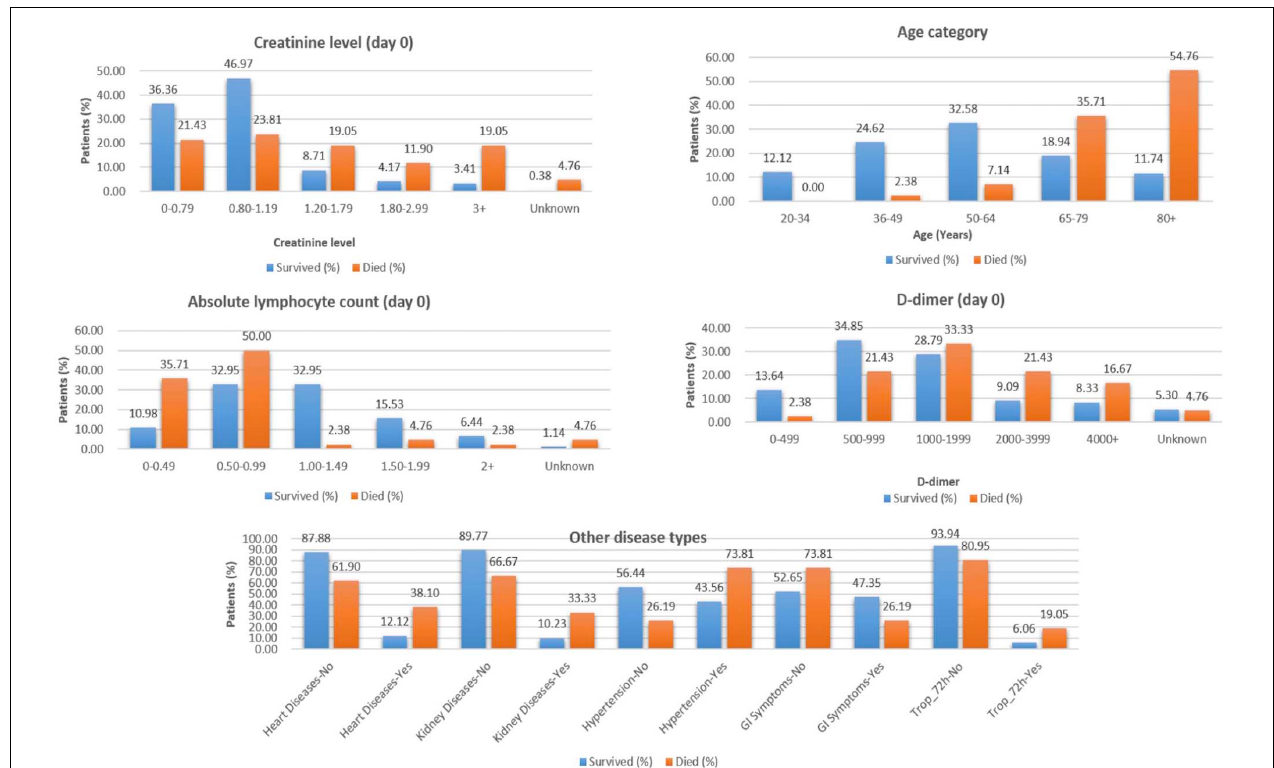
FIGURE 2 | Selected features from clinical data to classify COVID-19 patients who survived vs. those who died.